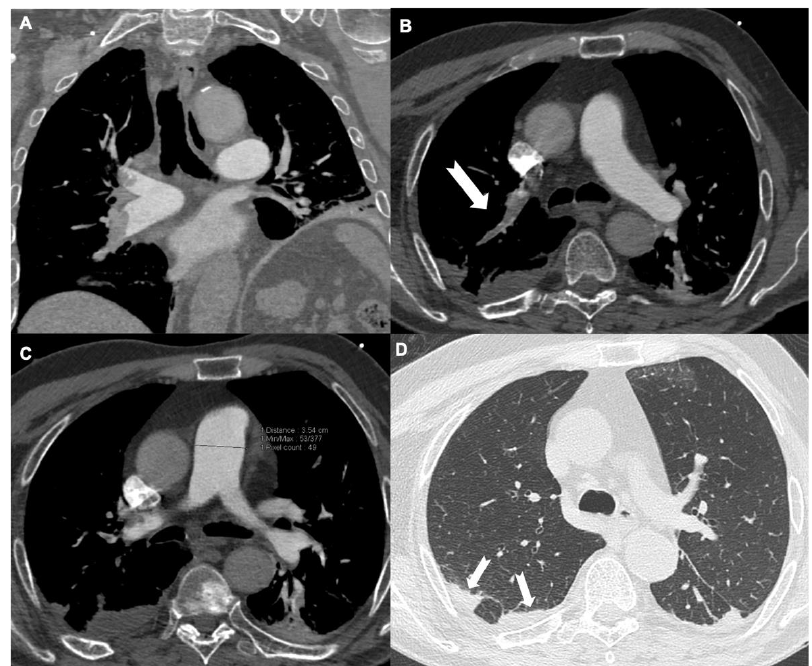
Figure 2. Patient with embolism involving pulmonary arterial branches for the right upper and lower lobe ( A ) and a sub-segmental branch for the right upper lobe (( B ), arrow). Pulmonary arterial trunk dilatation (35.4 mm) ( C ) and multiple pulmonary infarctions (( D ), arrows) are shown.